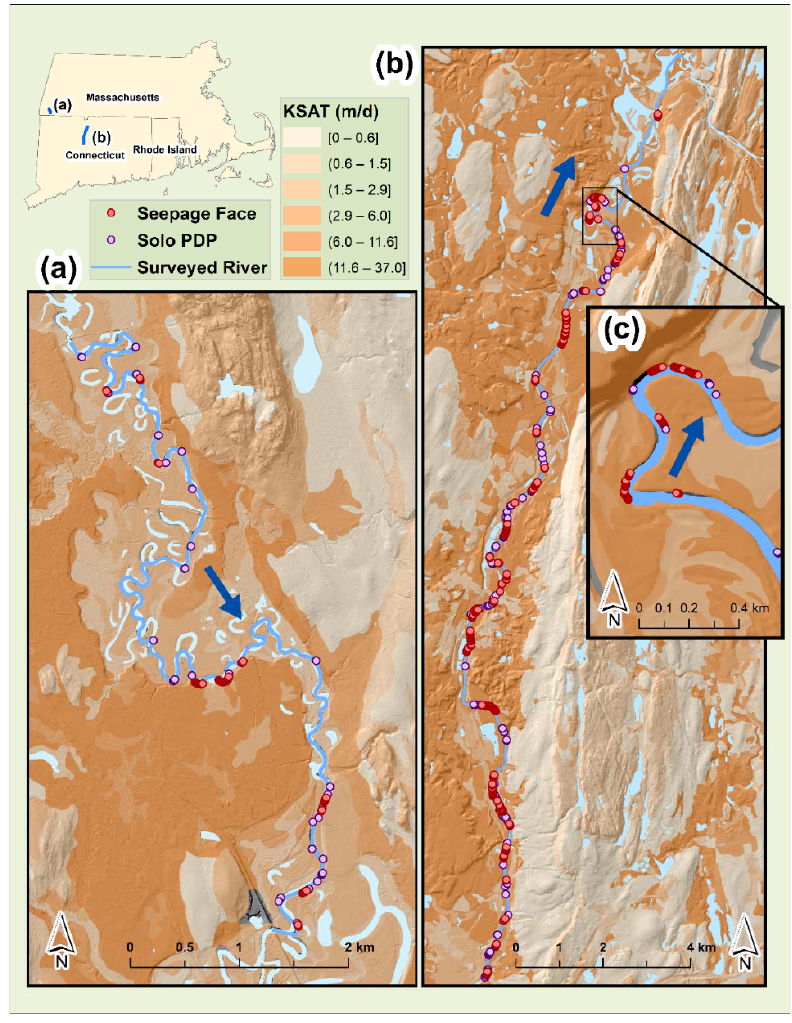
Figure 1. ( a ) The Housatonic River and ( b ) Farmington River fifth-order study reaches are shown in the context of surficial soils (SSURGO) saturated hydraulic conductivity (KSAT), along with PDPs (light pink) and more extensive seepage faces (dark pink) located with handheld thermal IR. Panel ( c ) shows a zoomed section of the Farmington River reach where seepage faces and PDPs occur along zones of relatively high apparent hydraulic conductivity sediments. Dark blue arrows indicate flow direction.